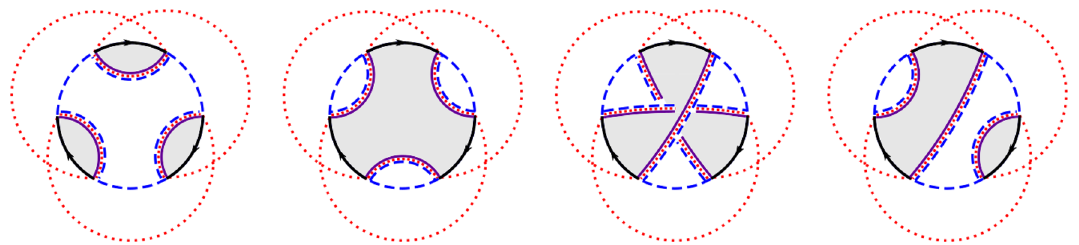
Figure 3 . The four classes of geometries which dominate the Rényi negativity calculation. In order, they are the disconnected ( g = 1 ), cyclic ( g = X ), anti-cyclic ( g = X − 1 ), and pairwise ( g = τ ) geometries. The pairwise geometries spontaneously break replica symmetry. The black lines are oriented asymptotic boundaries, the purple lines are EOW branes, the blue (dashed) lines denote k 1 index loops, and the red (dotted) lines denote k 2 index